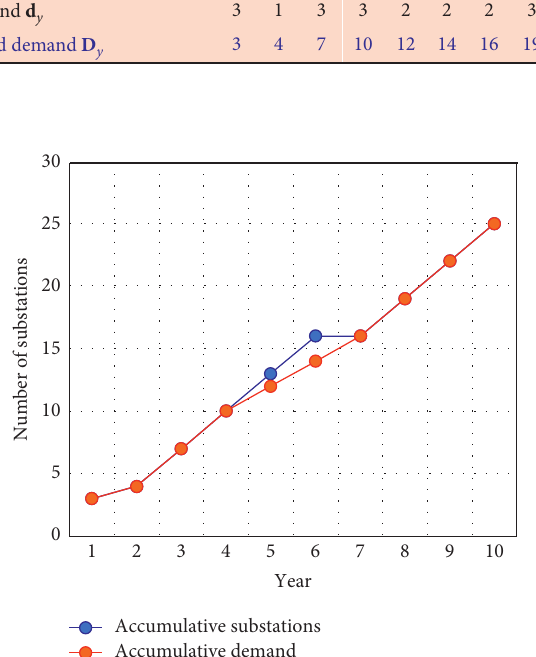
Figure 7: Accumulative number of demanded and established